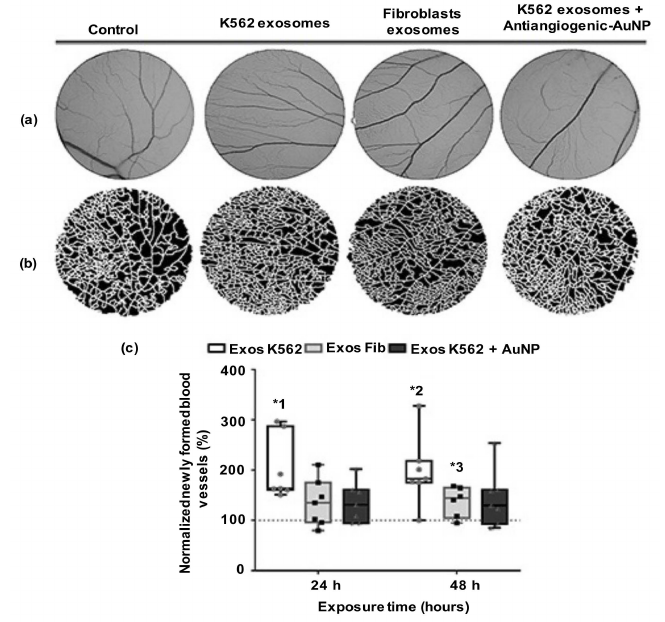
Figure 11. Response of antiangiogenic peptide-functionalized AuNPs in chorioallantoic-membrane model (CAM). Control areas are treated with PBS, K562 cells (50 µ g/mL) exosome, fibroblasts (50 µ g/mL) exosome, K562 exosomes (50 µ g/mL) and antiangiogenic loaded AuNPs (16.4 nM). ( a ) CAM-region images obtained using green channel. ( b ) Represented image segment used to compute newly formed branches. ( c ) Obtained results are presented in the whisker plots. Data were obtained from six independent experiments and normalized with corresponding CAM area at 0 h incubation after PBS exposure. The 100% normalized dotted line at newly formed vessels is considered as the control sample. *1 p -value 0.0113, *2 p -value 0.0212, and *3 p -value 0.040 compared to control. This figure is adapted from Rodrigues et al. (2019) [86], non-commercial uses of this work do not require any further permission from Dove Medical Press Limited, under the license (http://creativecommons.org/licenses/by-nc/3.0/, accessed on 29 January 2022).